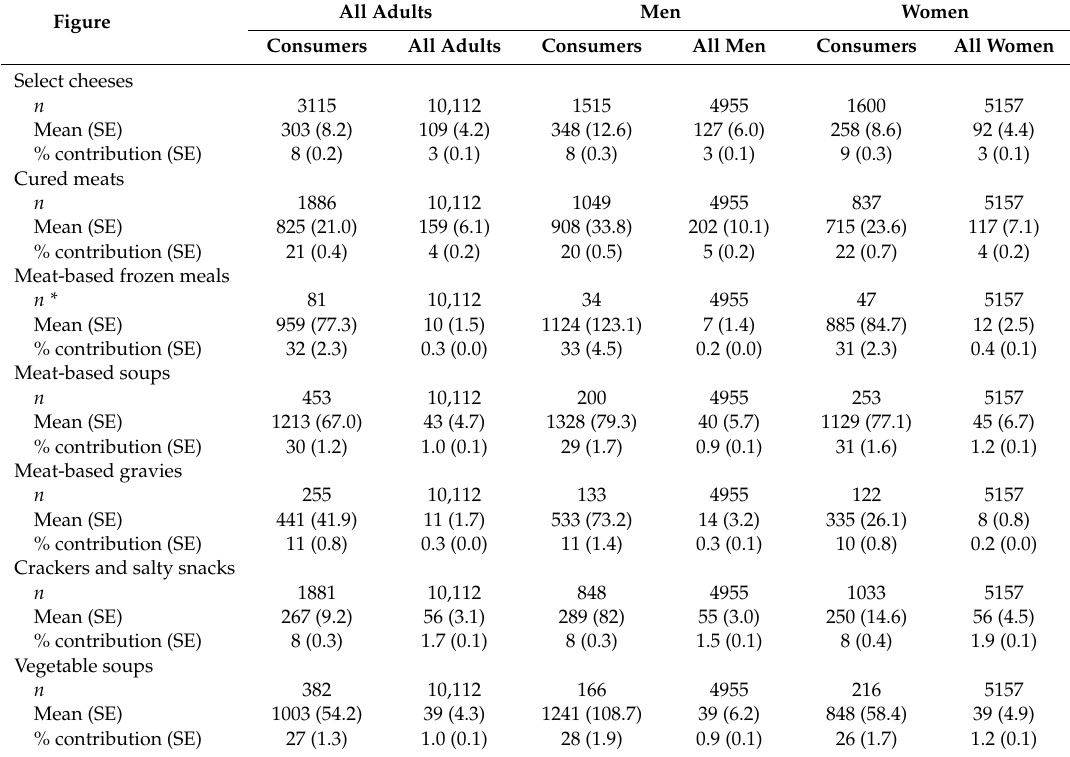
Table 4. Estimated mean sodium intake (in milligrams) and percentage-wise contributions from selected food groups in the diets of U.S. adults (aged ≥ 19 years) by age and sex, NHANES 2013–2016 1,2,3 . All Adults Figure